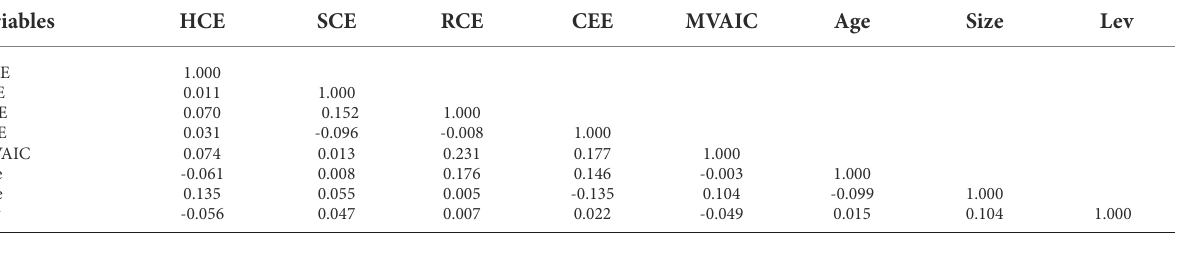
Table 6 Regression analysis of Indian firms.